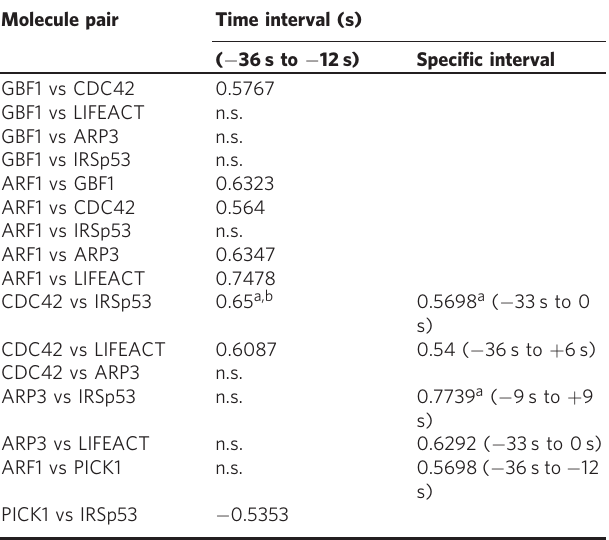
Table 2 Cross-correlation calculated for indicated